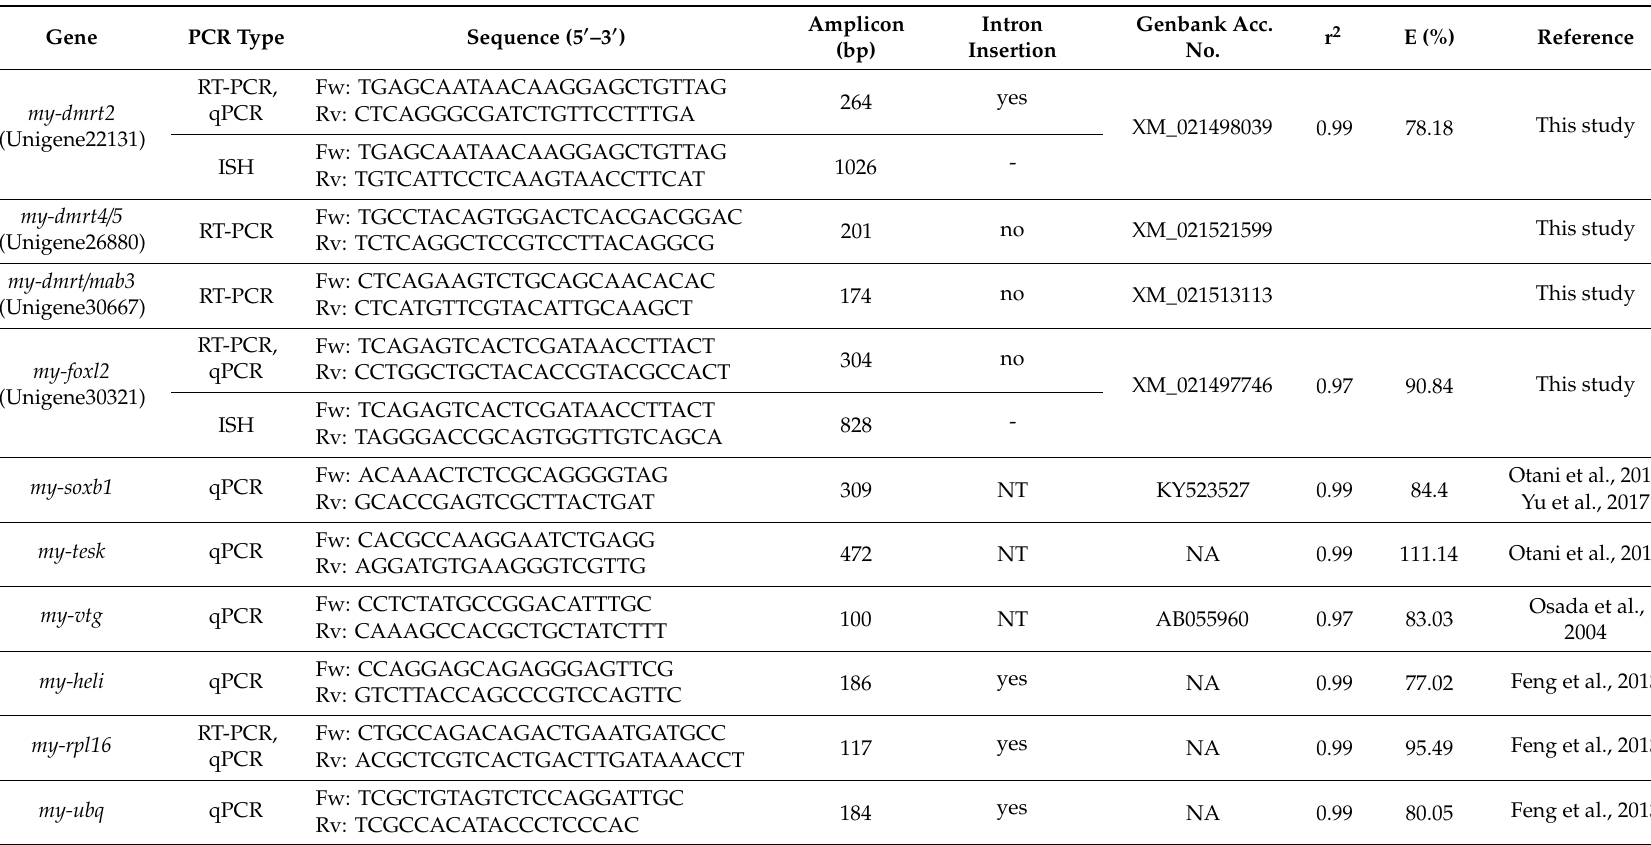
Table 2. Gene names, type of PCRs, primer sequences, amplicon sizes (bp), intron insertion in the amplicon, GenBank accession numbers, r squared value (r 2 ), PCR e ffi ciency (E, %) and references for my-dmrt2 , my-dmrt4 / 5 , my-dmrt / mab3 , my-foxl2 , my-sox , my-tesk , my-vtg , my-heli , my-rpl16 , and my-ubq in the Yesso